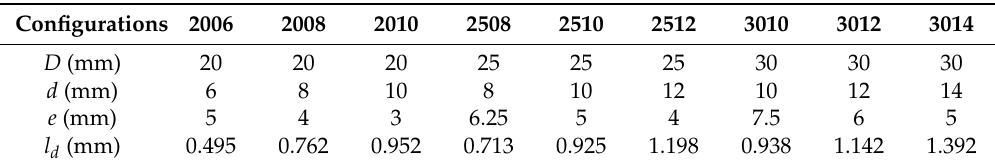
Table 2. Configurations of the eccentric cylinder.